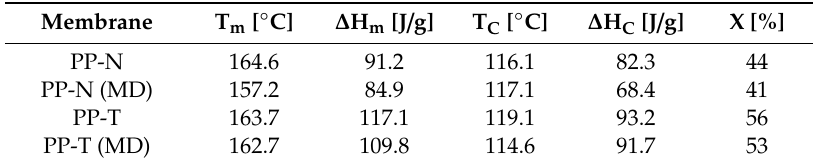
Table 3. The results of di ff erential scanning calorimetry (DSC) analysis of new membranes and membrane samples after MD